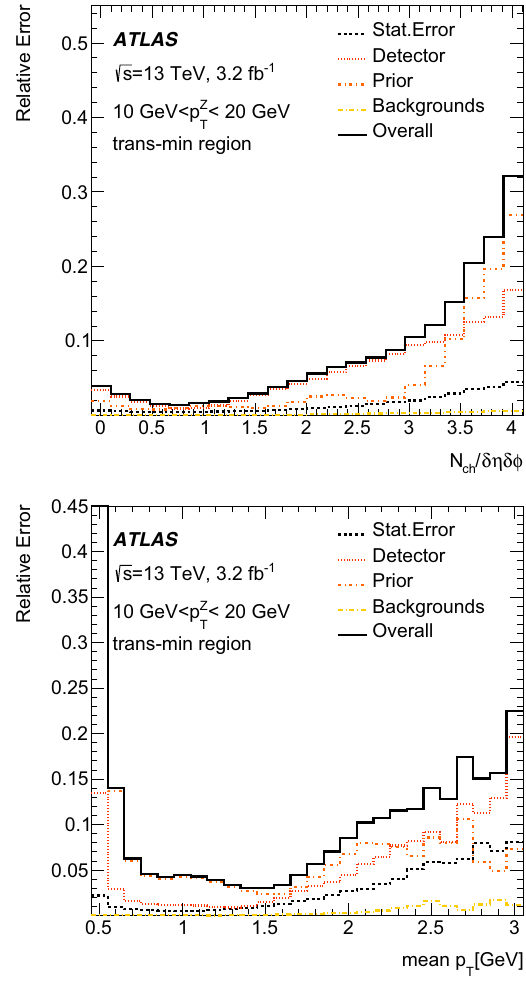
Fig. 2 Breakdown of systematic uncertainties in the p T spectrum (upper left), the charged-particle multiplicity ( N ch , upper right), the scalar sum of the transverse momenta ( (cid:8) p T , lower left) and the mean transverse momentum (mean p T , lower right) for events with 10 < p Z